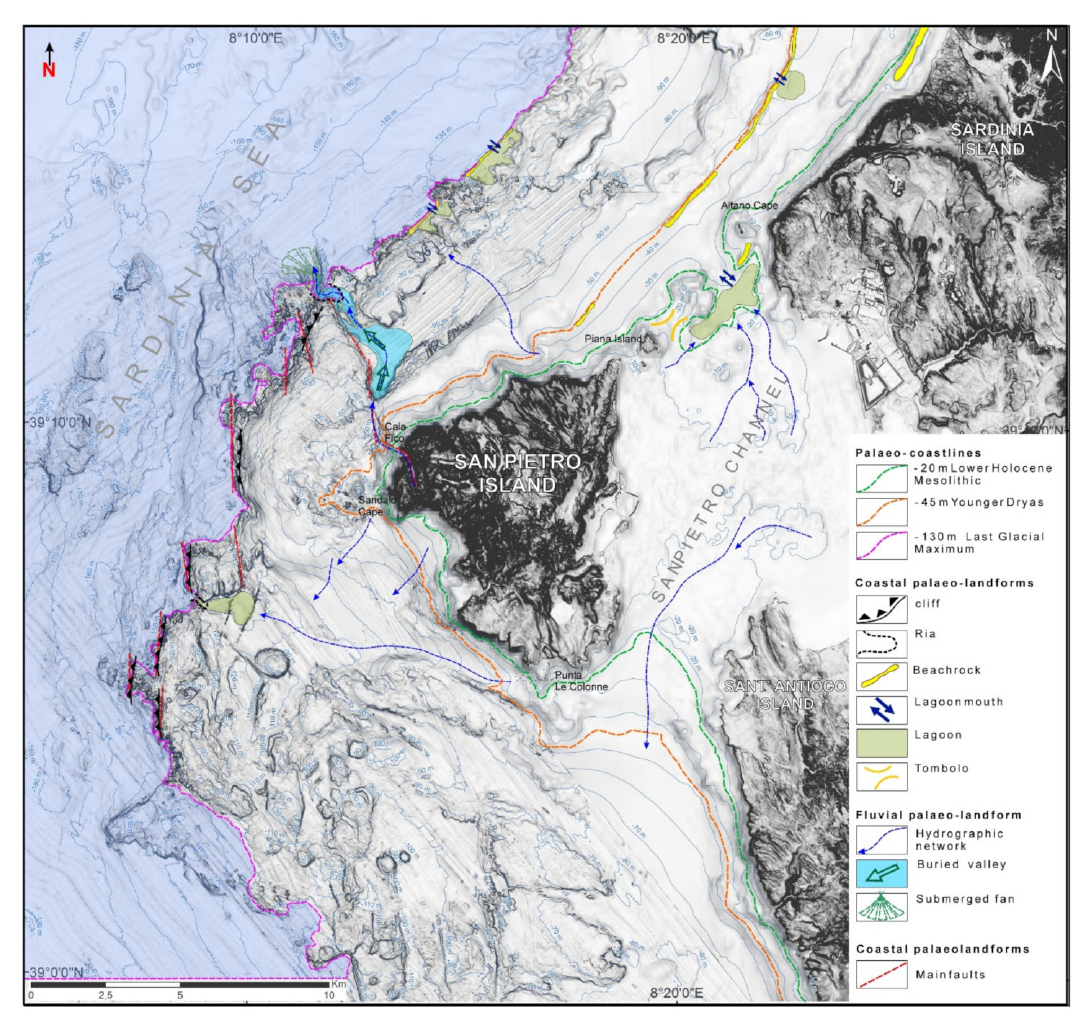
Figure 14. Geomorphological sketch of the San Pietro continental shelf. Submerged palaeo-landscape since LGM (20 ka) to 9